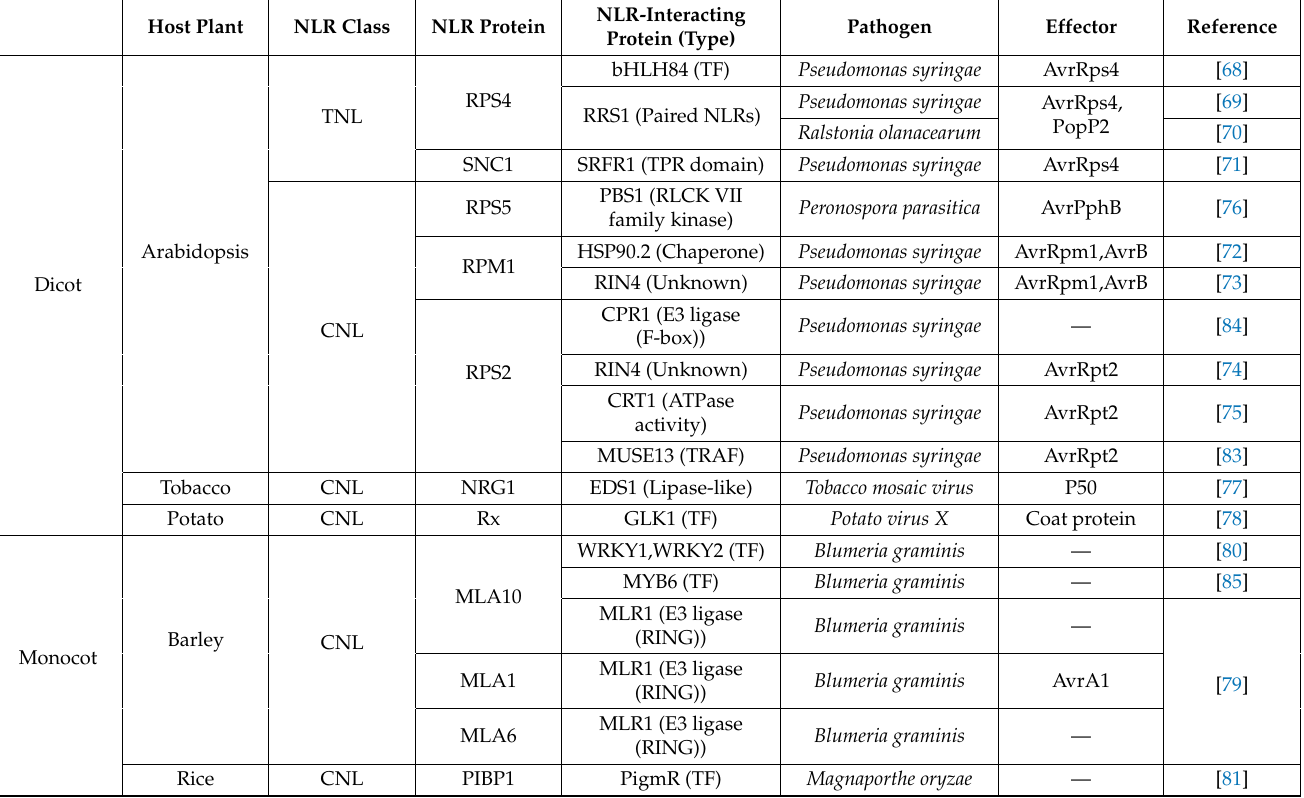
Table 4. NLR protein resistance in different crops and their intercrossing